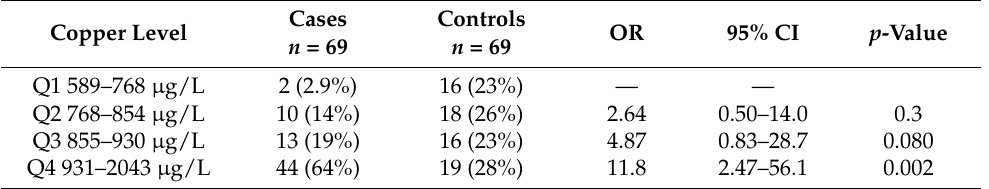
Table 10. Blood copper levels and the occurrence of colorectal cancer among patients with metastases.